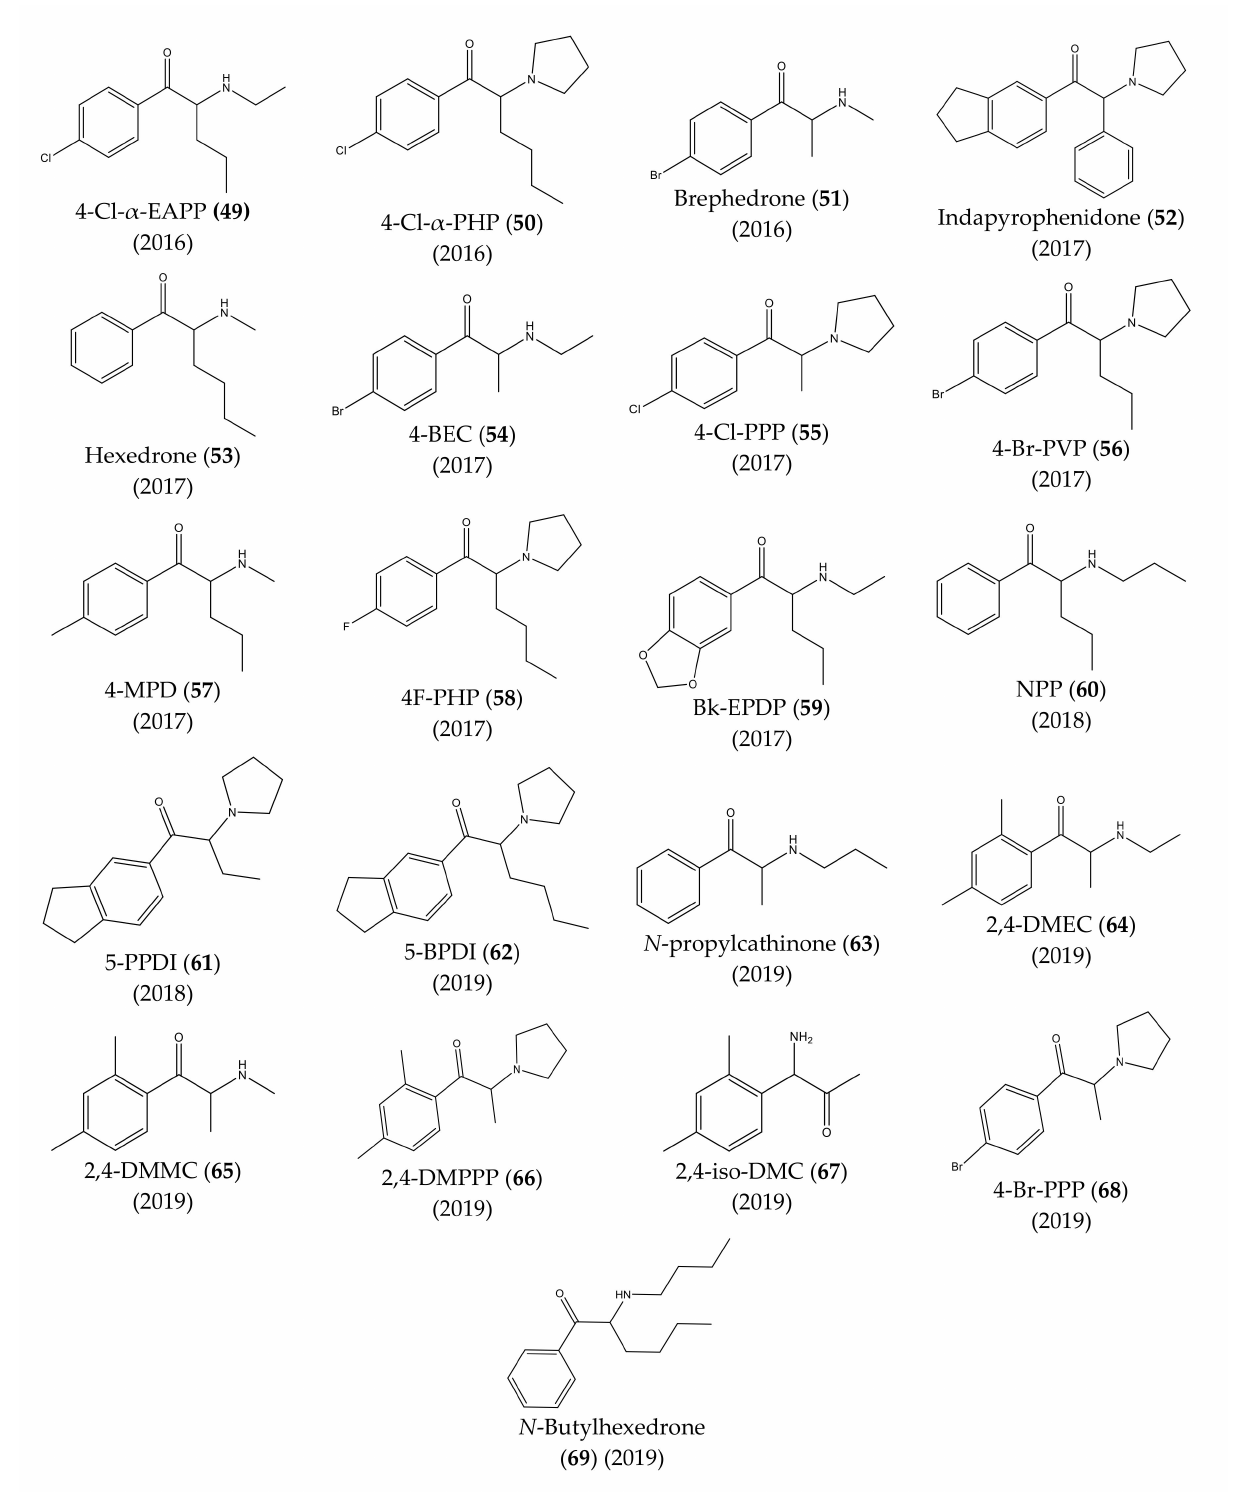
Figure 8. Structures of the most recent cathinone derivatives ( 49 )–( 69 ). In 2017, an unknown compound found in seized drugs in the UK was identified and characterized as indapyrophenidone ( 52 ), a novel cathinone derivative [30]. Addi- tionally, hexedrone ( 53 ), 4-BEC ( 54 ), 4-Cl-PPP ( 55 ) and 4-Br-PVP ( 56 ) were first reported in Poland [13,31]. Furthermore, in the same year, three emerging cathinone